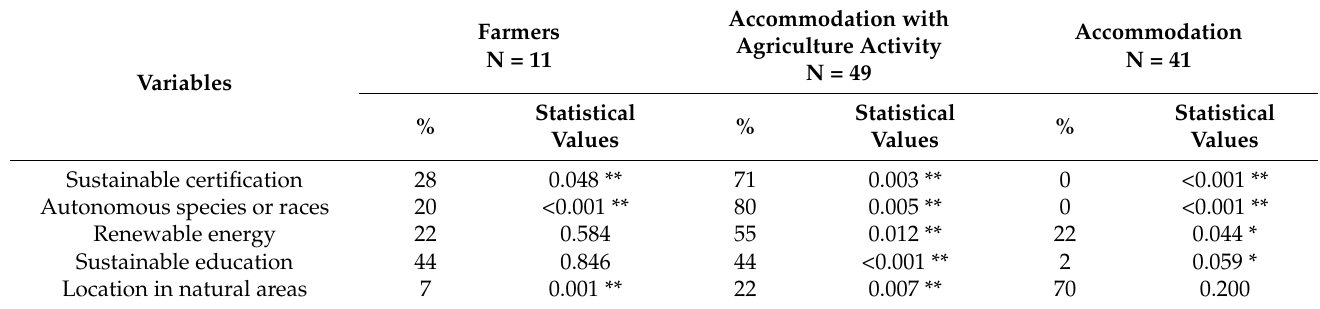
Table 8. A comparison of environmental variables between accommodation and other entrepreneurial agritourism models (Chi-square analysis of dummy